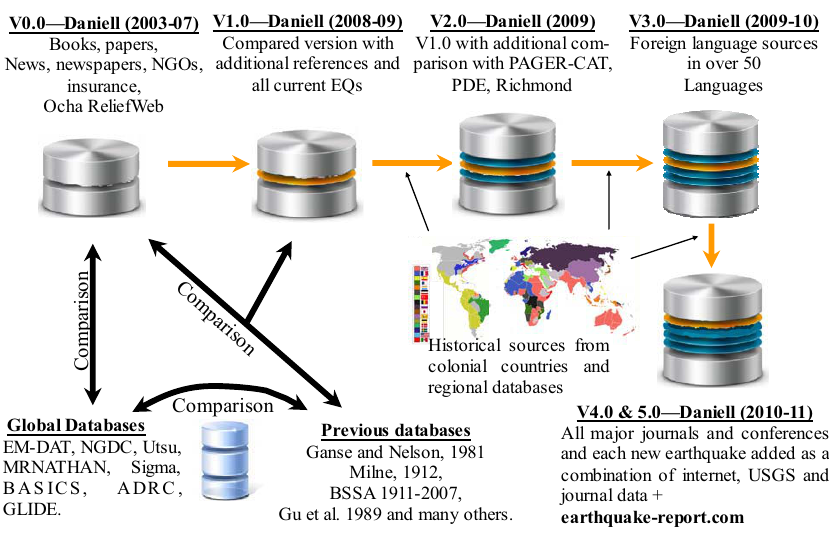
Fig. 1. Flowchart of the process to create the various versions (v0.0 to v5.02) of the CATDAT Damaging Earthquake Database from 2003 to